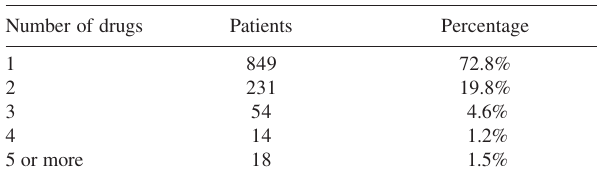
Table 1 - Anti-infective drugs in the treated population (Test group, n = 1166)